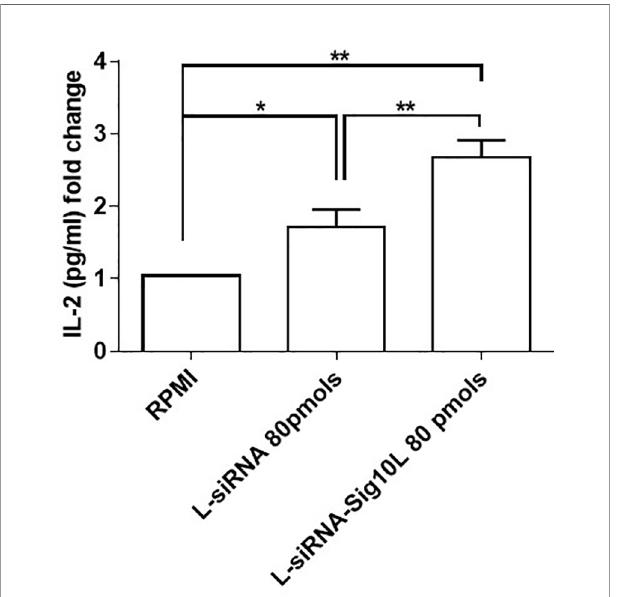
FIGURE 6 | IL-2 detection in supernatants of transfected then anti-CD3/CD28 stimulated PBMC. IL-2 secretion upon 5 days of anti-CD3/CD28 activation (bead to cell ratio 1:50) in culture supernatants of T1D C1858T PTPN22 HET PBMC transfected O/N with LiposiRNA-Sig10L at the dose of 80 pmols. Data are expressed as mean ± SEM of n = 5 *p < 0.05, **p <